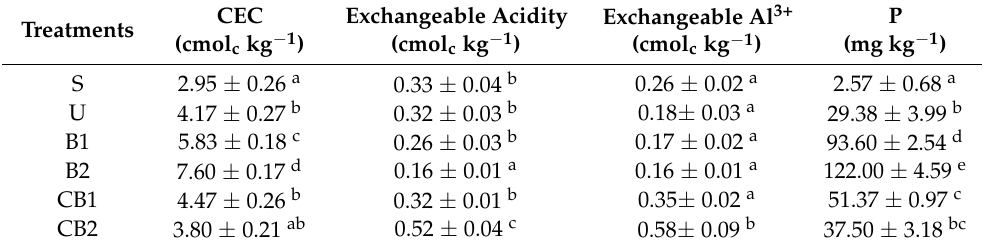
Mean values within column with different letter(s) indicate significant difference between treatments by Tukey’s test at p ≤ 0.05. Columns represent the mean values ± SE. The treatments evaluated were: S: Soil only, U: